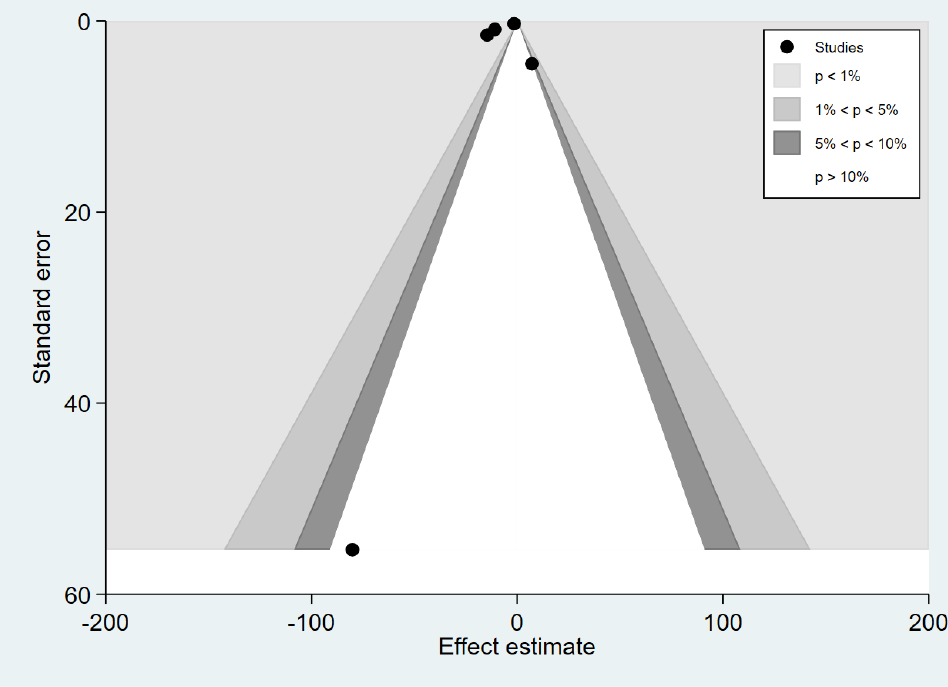
Figure 11. Contour-enhanced funnel plot demonstrating the MD in TGF-β levels between severe and uncomplicated malaria (pg/mL) in the significant area (pale grey area) and non-significant areas (white and dark grey colours), indicating that the cause of funnel plot asymmetry was the heterogeneity of the effect estimates and the publication bias.